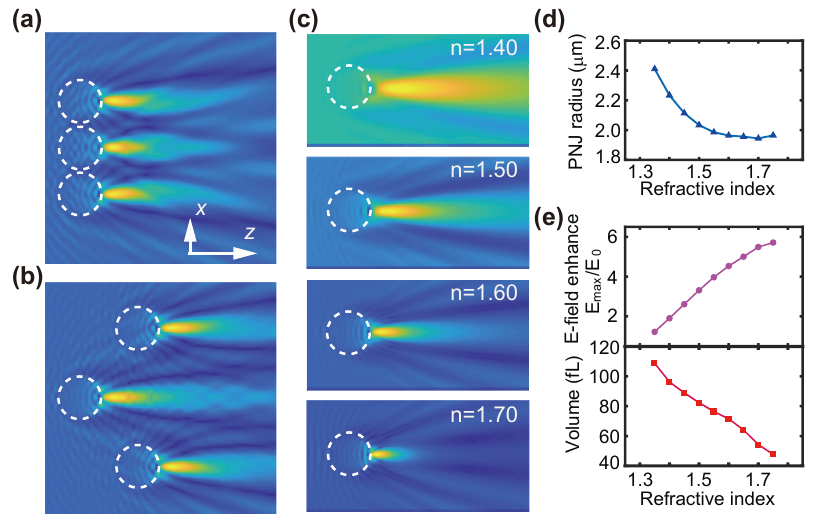
Figure 1: Self-induced PNJ innately moves along the microsphere. The PNJ formed by 2 μ m-diameter polymer microspheres (dashed lines)alignedin(a) the same and(b) different transverse planes. (c) The sideview profiles of the light intensity formed with a 2 μ m diameter polymer sphere with various values of optical refractive index. (d) The effective radius of the PNJ as function of the refractive index of the microsphere. (e) The maximum electric field enhancement inside the nanojet increases with the refractive index, while the effective volume of the PNJ decreases with the refractive